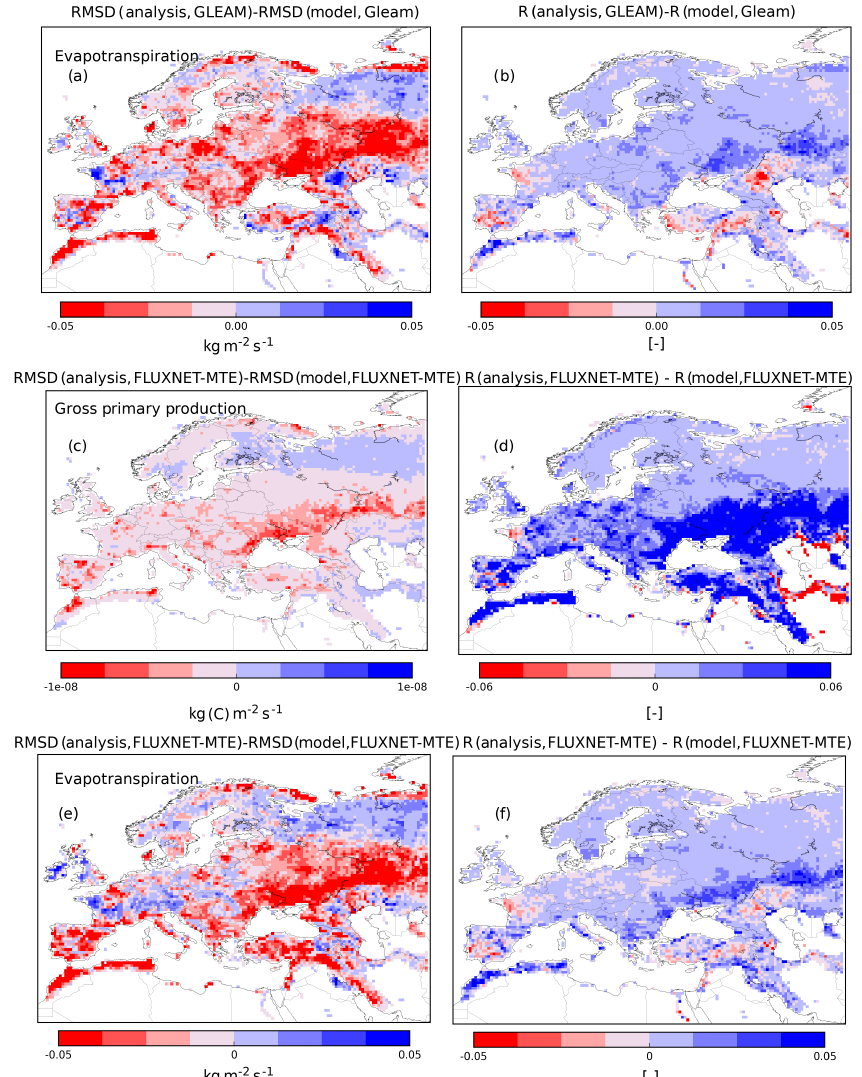
Figure 14. RMSD (a) and correlation (b) differences between analysed (modelled) evapotranspiration and GLEAM estimates over 2000– 2012. Panels (c, d) are similar to (a, b) for carbon mass flux out of the atmosphere due to gross primary production (GPP) from the analysis (model), and FLUXNET-MTE GPP estimates over 2000–2011. Finally, panels (e, f) are similar to (a, b) for analysed (modelled) evapotranspiration and FLUXNET-MTE evapotranspiration estimates over